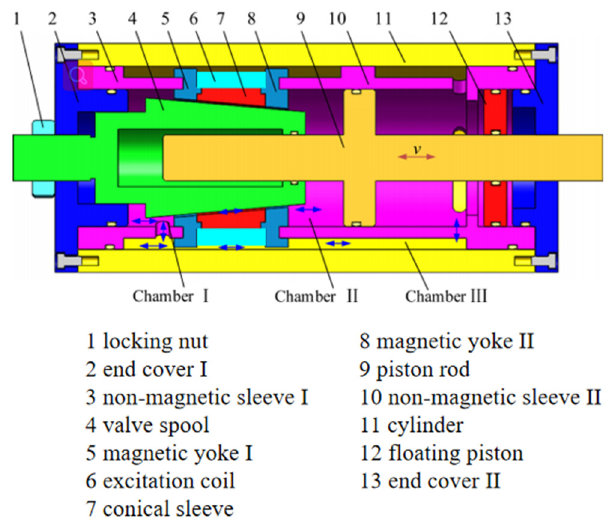
Figure 9. MRD with tapered fluid channel MRD [62,63].